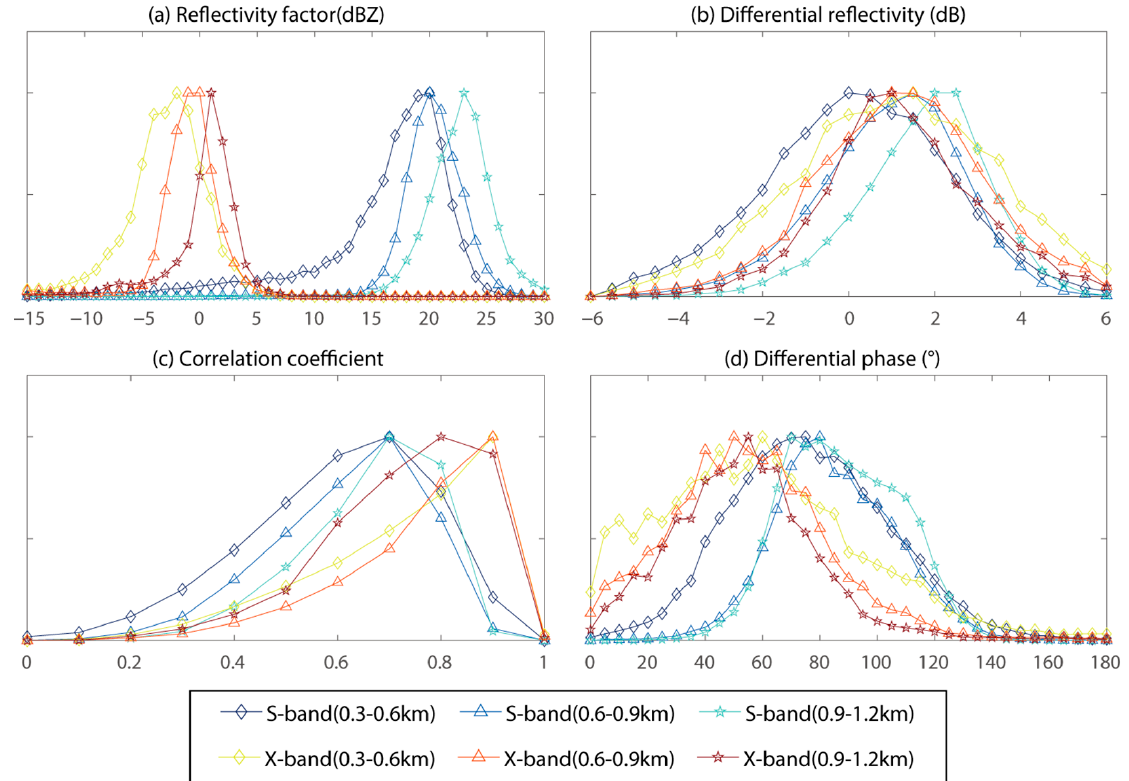
Figure 15. Histograms of the radar products of the CINRAD/SA (S-band) and X-POL (X-band), respectively, on 2 May 2021 at 13:00 UTC for a height ranging between 300 m and 1.2 km.